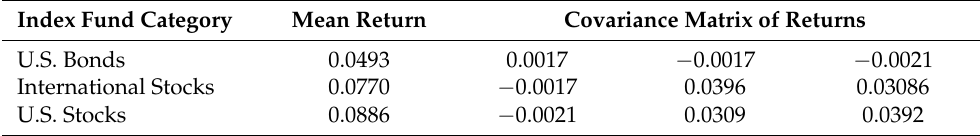
Table 1. Summary statistics on returns from January 1998 to December 2017 for our three index funds. Index Fund